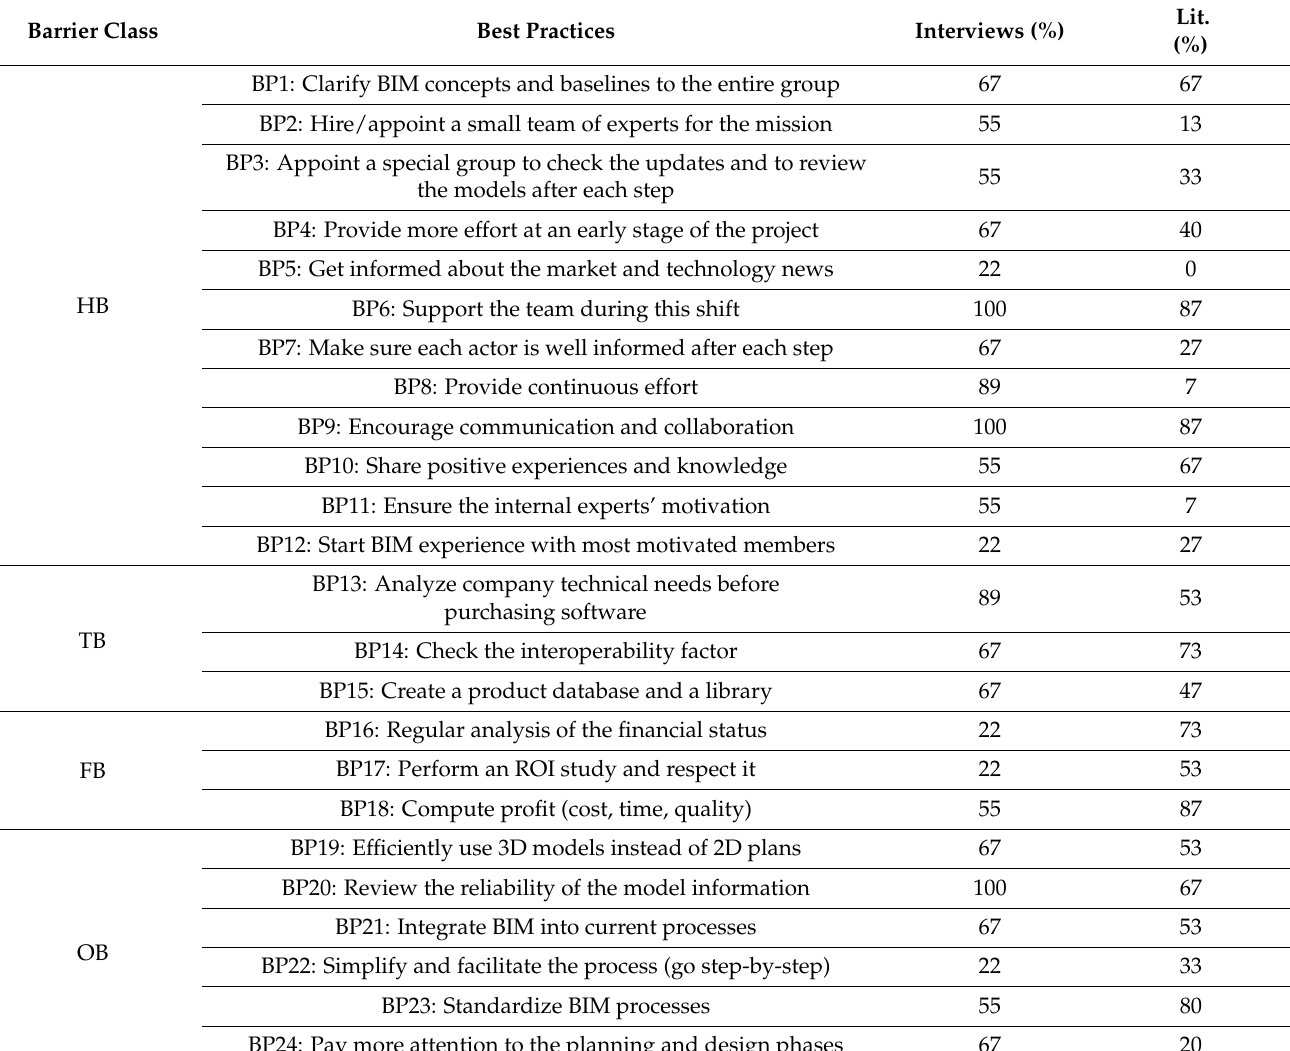
Table 3. Best practices for BIM adoption using the interviews and literature outcomes. Barrier Class Best Practices Interviews (%)